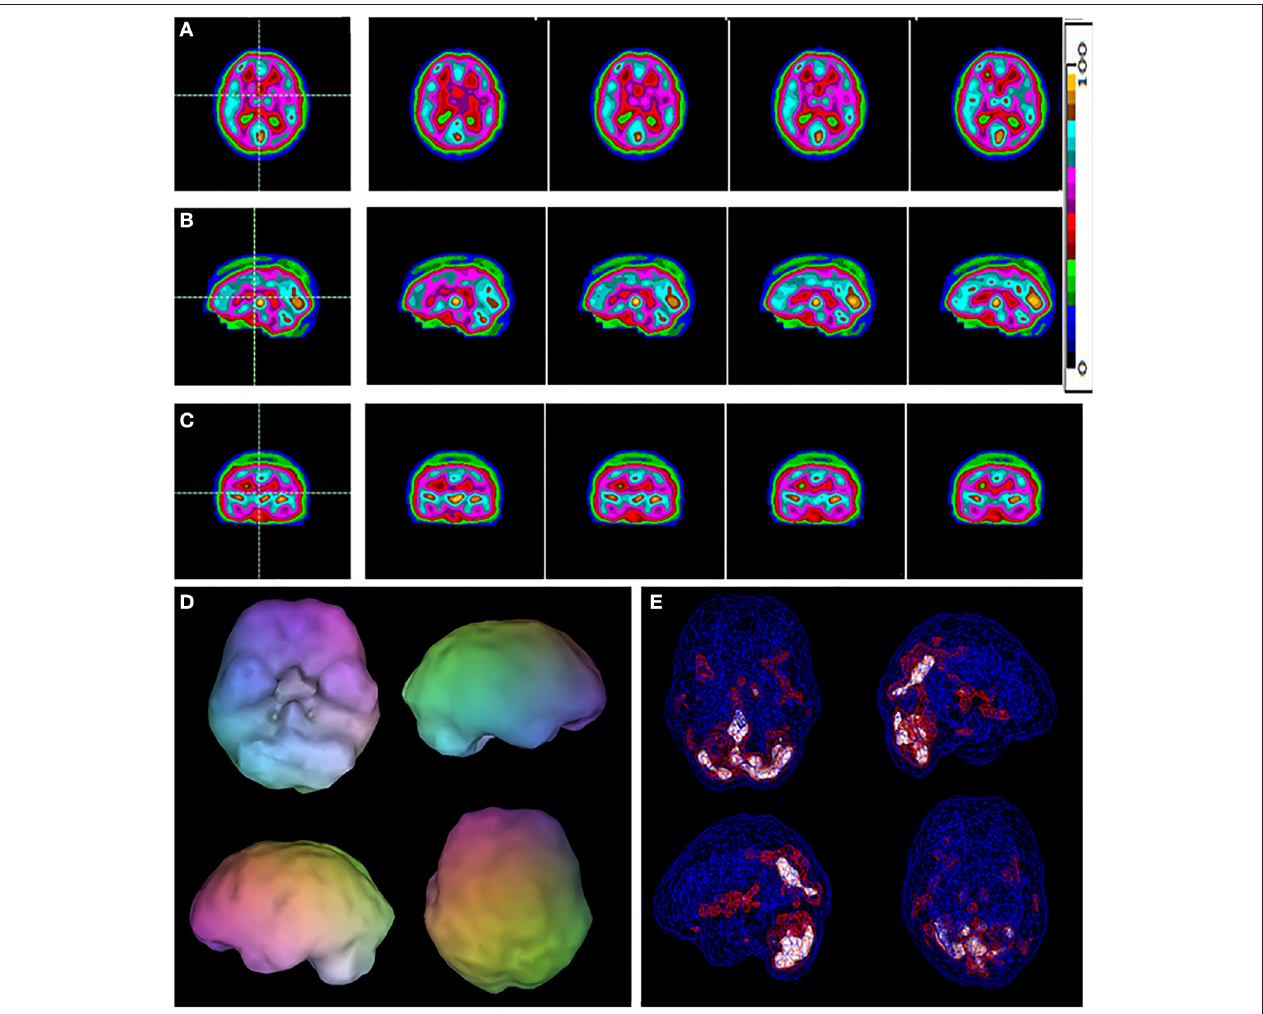
FIGURE 1 | A typical example of a control case. Selected tomograms in horizontal (A) , sagittal (B) , and coronal (C) orientation are provided. The color scale for the tomograms is provided. All voxels are scaled to the brain maximum and assigned each a color gradient based on its percentile of activity. Each color step represents a (not necessarily linear) five-percentile-point change in rCBF. (D) A 3-D representation of the scan data is shown. The surface is set at 60% of brain maximum. Areas which fall below 55% are represented as indentations or holes depending on how far below 55% the activity falls. (E) A wireframe brain representation is shown, wherein the areas of brain with activity at 85% of maximum or greater are shown in red and areas of 92% or greater are shown in